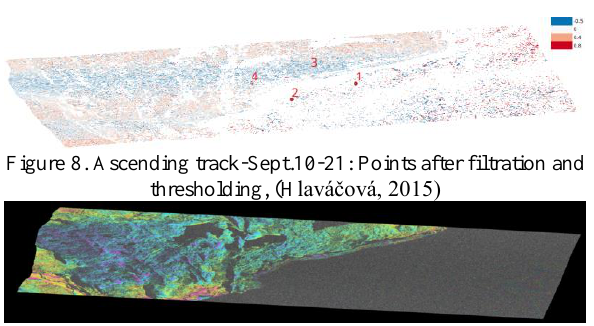
Figure 7. Ascending track-Sept.10-21: Interferogram after filtration, (Hlaváčová, 2015)